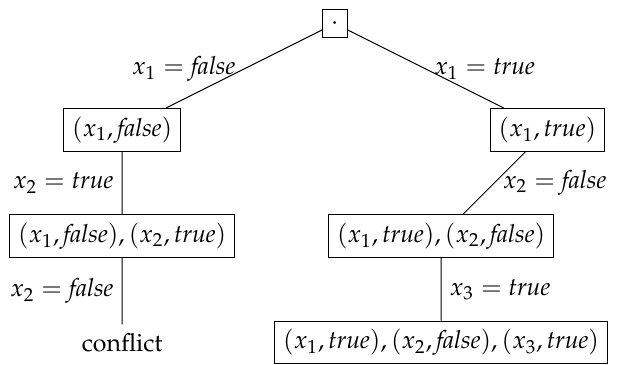
Figure 1. The search space of the DPLL algorithm on the formula in Example 1. Each node contains the current truth assignment and the edges represent assignments made by the algorithm. Vertical edges represent unit propagations, whereas the oblique edges represent decisions.